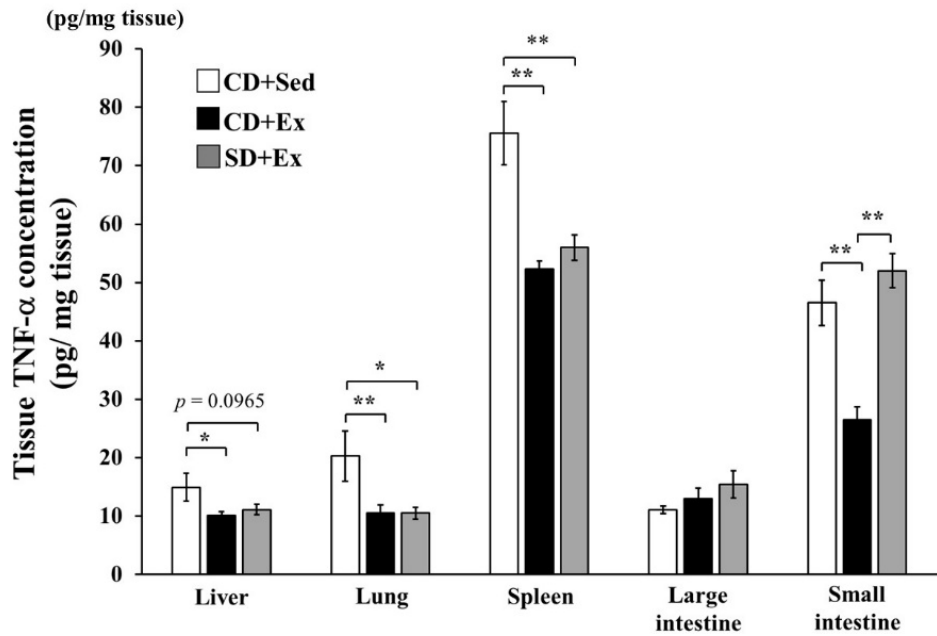
Figure 2. The e ff ect of exhaustive exercise and Sparassis crispa intake on TNF- α concentration in the liver, lung, spleen, large intestine and small intestine of mice. Values are means ± SEM. * p < 0.05, ** p <